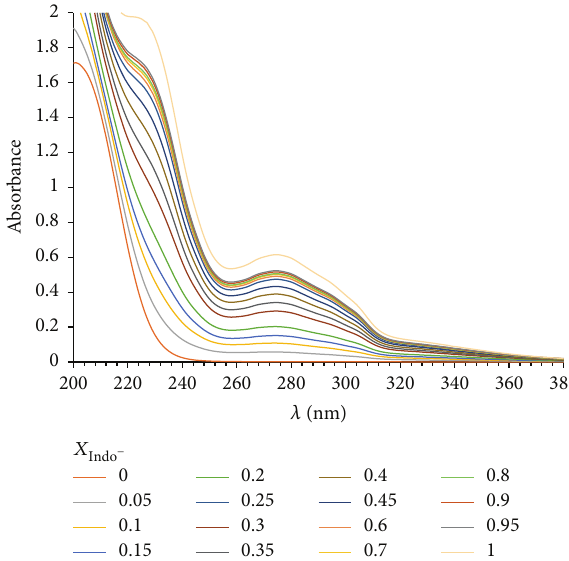
Figure 9: Absorption spectra for Cu(II)–Indomethacin in water using the continuous variations